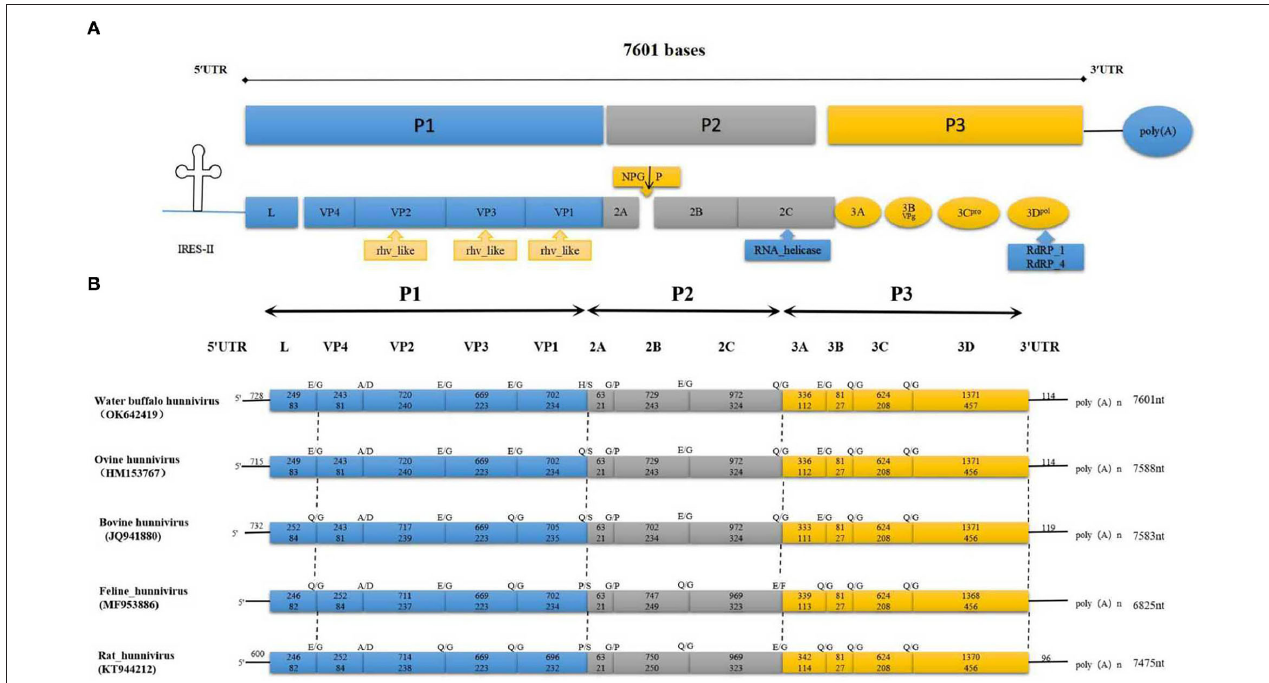
FIGURE 2 | The complete genome and conserved motifs in the BufHuV-GX-2106 strain. (A) Diagrammatic representation of the complete genome consisting of a large ORF, 5 ′ UTR, 3 ′ UTR and poly A tail. P1 represents viral structural proteins and P2 and P3 represent non-structural proteins. The predicted conserved rhv-like domain, RNA helicase and RDRP in the large ORF coding region of BufHuV-GX-2106 are indicated adjacent to the arrows along the coding regions. (B) A comparison of the predicted cleavage sites among the referenced hunnivirus types. The predicted potential cleavage sites are, respectively, indicated above the arrows along the coding regions.